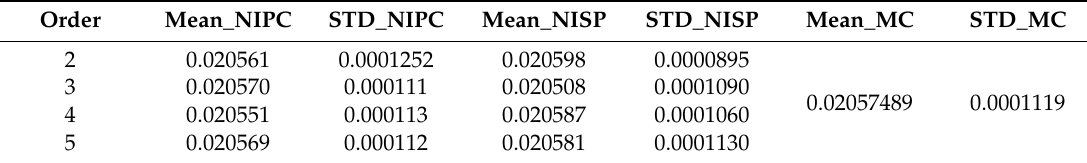
Table 8. The mean and standard deviation of the drag coefficient (C D ) values for A-airfoil.